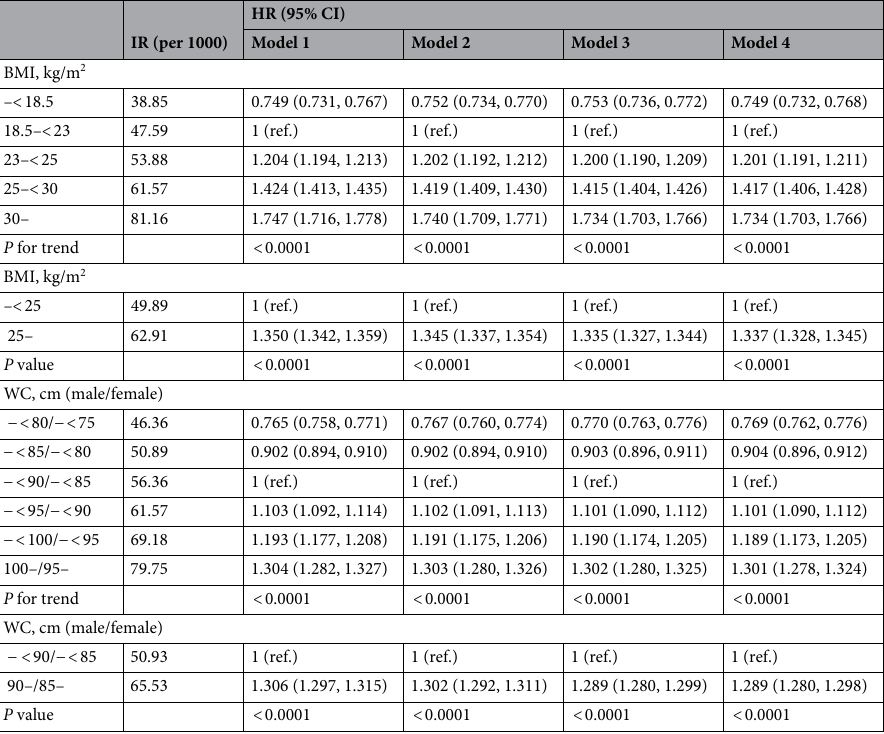
Table 2. Incidence rate and hazard ratio for the risk of knee OA according to BMI and WC. Model 1 was adjusted for age, sex. Model 2 was adjusted for age, sex, income, smoking, alcohol intake and regular exercises. Model 3 was adjusted for age, sex, income, smoking, alcohol intake, regular exercises, diabetes, hypertension and dyslipidemia. Model 4 was adjusted for age, sex, income, smoking, alcohol intake, regular exercises, diabetes, hypertension, dyslipidemia, cancer, end-stage renal disease, chronic obstructive pulmonary disease, stroke, liver cirrhosis, hear failure, dementia and chronic kidney disease. BMI body mass index, WC waist circumference, HR hazard ratio, CI confidence interval, OA osteoarthritis, IR incidence rate.